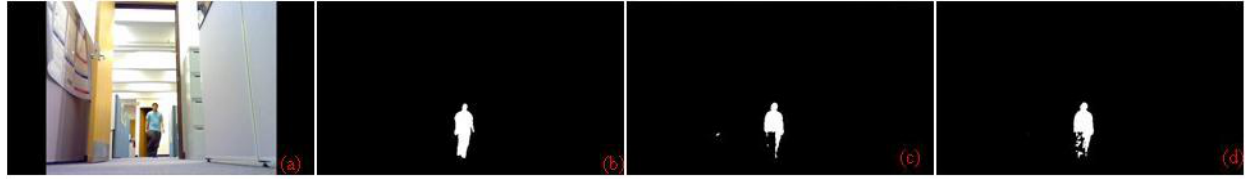
Figure 13. Simulation results for the colour similarity case. ( a ) Input ( b ) Ground truth ( c ) Method: Li et al. ; ( d ) Method: Zulkifley et al .